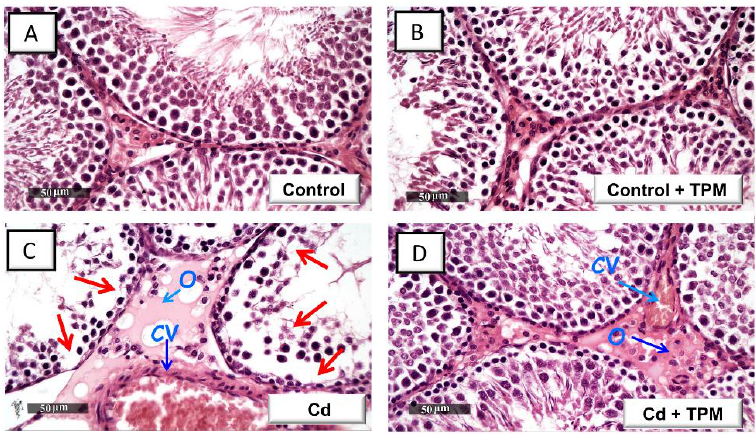
Figure 2. Topiramate ameliorates the histologic aberrations in cadmium-induced testicular injury in rats. The testicular histomorphological changes were examined by microscopy after staining with hematoxylin and eosin (H-E) stain. Typical morphology of the seminiferous tubules, their germinal epithelium lining, and interstitial tissue were observed in the control group ( A ) and topiramate-treated control group ( B ). In cadmium-intoxicated rats, severe atrophy of the seminiferous tubules, notable degeneration of the germinal cells (red arrow), interstitial edema (O), and congestion of interstitial blood vessels (CV) were observed ( C ). These histologic changes were mitigated by administration of topiramate as manifested by the typical seminiferous tubules which were lined with intact germinal epithelium ( D ). However, focal areas of mild interstitial edema (O) and congested blood vessels (CV) were still observed. TPM, topiramate; Cd, cadmium